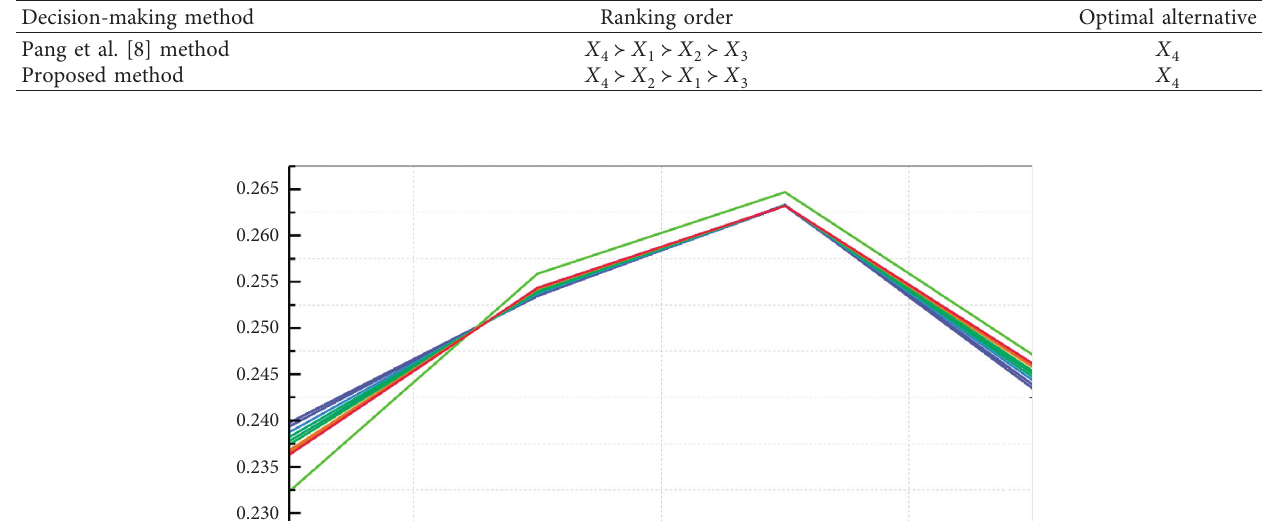
Table 11: Comparison results with the method of Pang et al. [8].